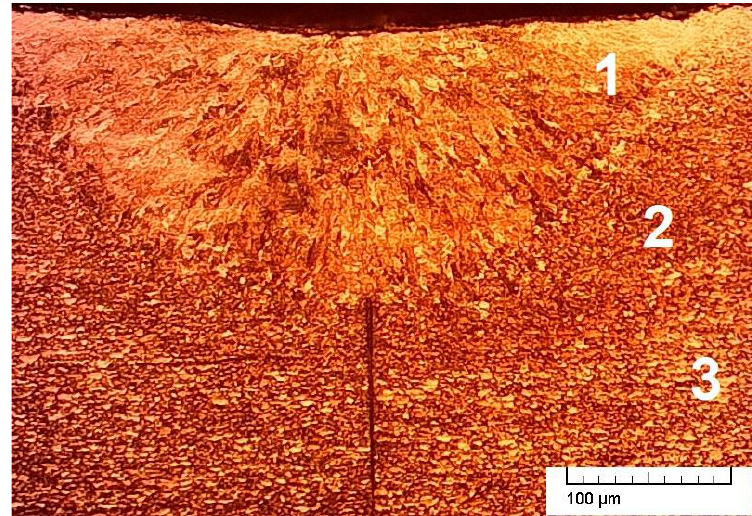
Figure 1. Typical cross-section of the laser butt welding zone of the upper layer of a steel – polymer three-layer composite sample at a pulse duration of 1 ms: 1 — remelted zone with a developed interdendrite microheterogeneity; 2 — heat-affected zone; 3 — initial metal.